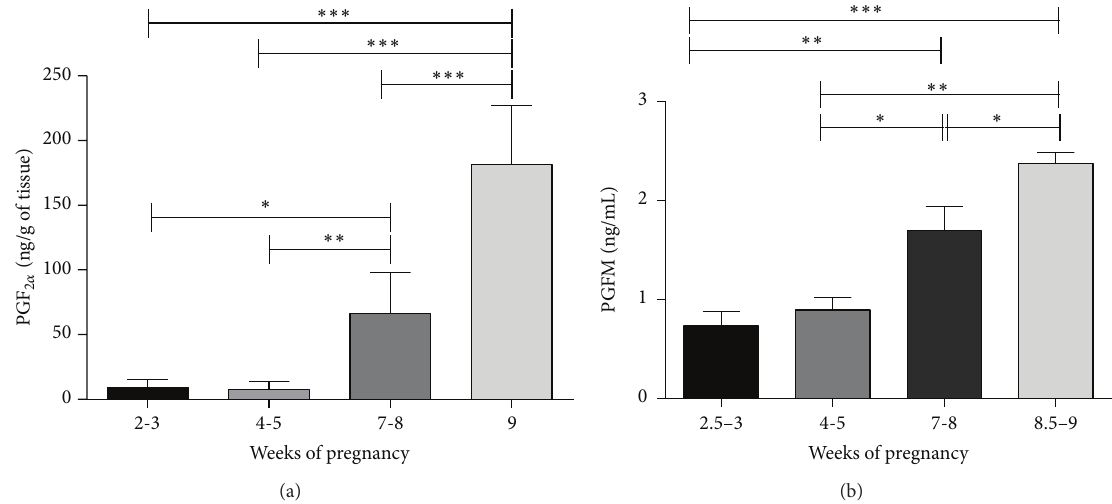
Figure 5: Placental PGF 2𝛼 and serum PGFM values. Time-dependent content of PGF 2𝛼 in placenta (a) and PGFM in blood plasma (b) as determined by immunoassays. Asterisks indicate statistical differences between prostaglandin levels during the course of pregnancy ( ∗ 𝑃 < 0.05 , ∗∗ 𝑃 < 0.001 , and ∗∗∗ 𝑃 < 0.0001